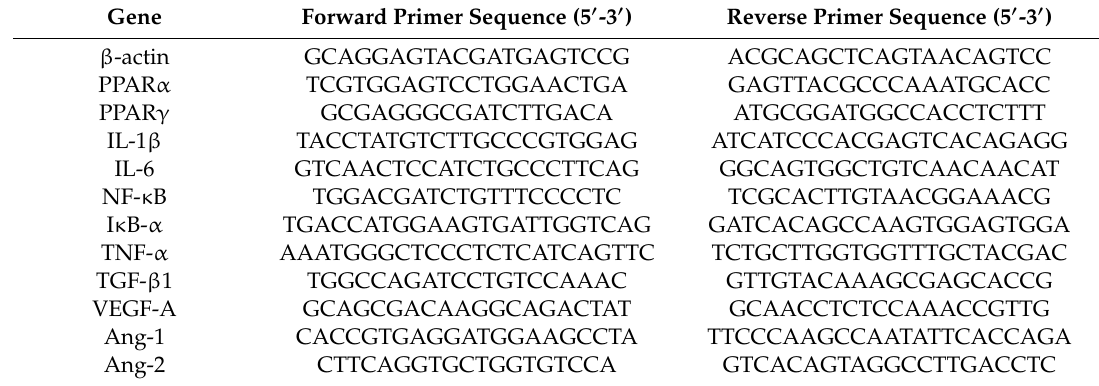
Table 1. Primer pairs used in this